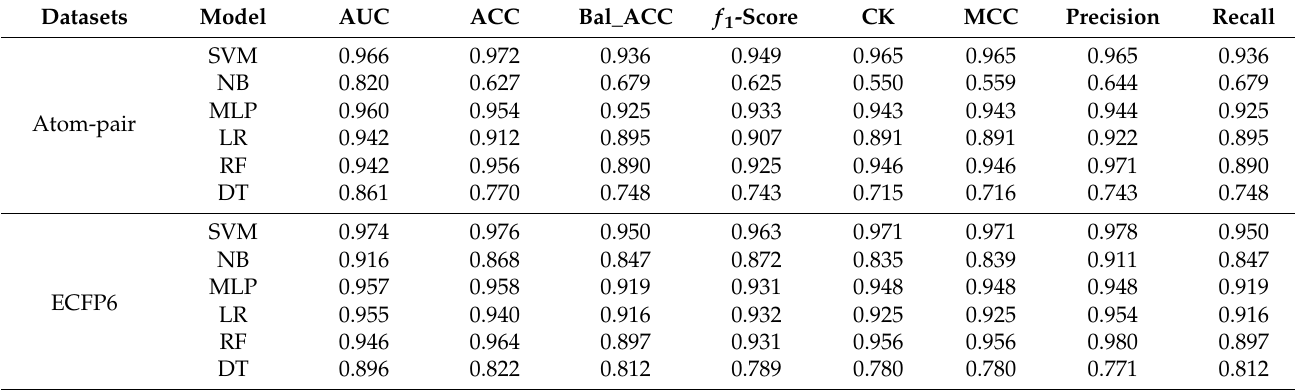
Table 2. Results of the Test Set on Each Dataset with One Feature Type.